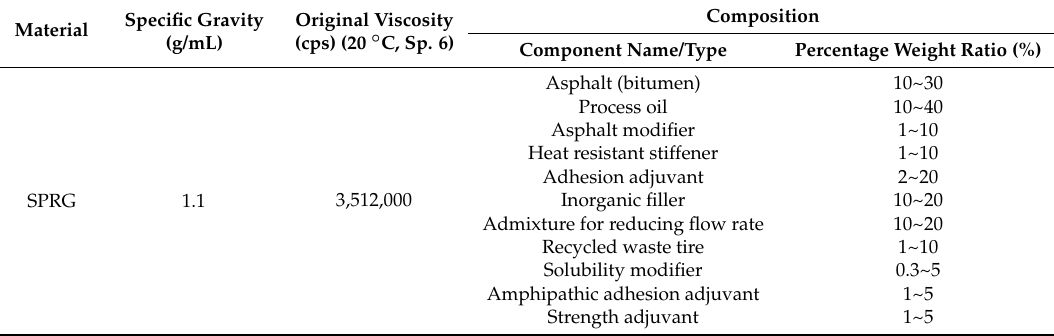
Table 1. Synthetic polymerized rubber gel structural component list and